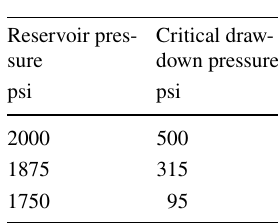
evaluated, and Table 2 summarizes the critical drawdown pressure corresponding to onset of sand production for dif- ferent reservoir pressures.